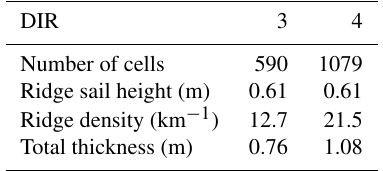
Table 1. Comparison of ice ridge statistical parameters derived from the HEM data with ice chart degrees of ice